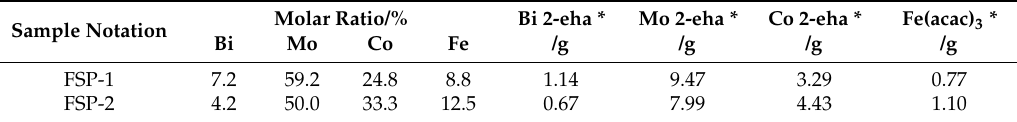
Table 1. Amounts and ratios of flame spray pyrolysis precursors